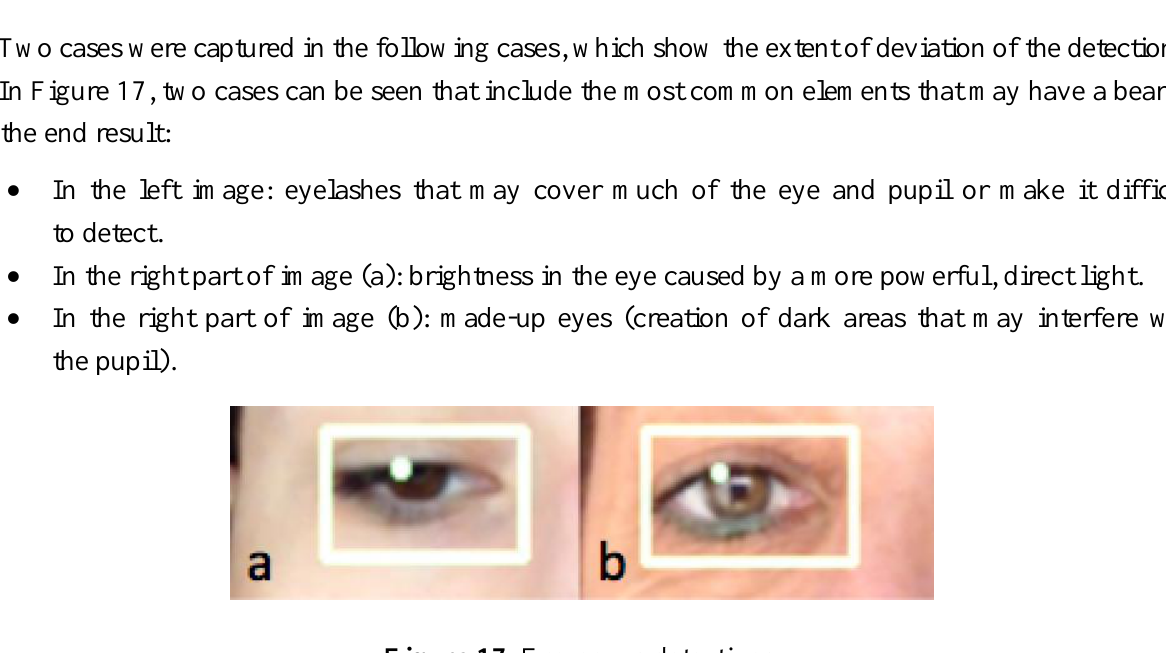
Figure 17. Erroneous